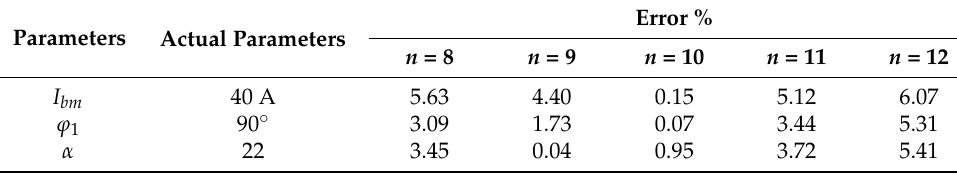
Figure 4. Waveform for different values of n . Table 1. Error in waveform parameters when n is taken as different values. Parameters Table 1. Error in waveform parameters when n is taken as different values.